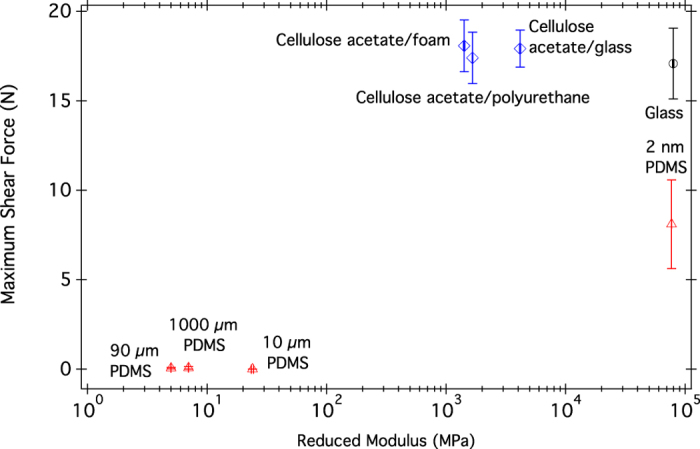
Average maximum shear force of adhesion for whole animals on cellulose acetate and PDMS substrates as a function of the surface modulus of the substrates (as measured using a nanoindenter).Individual points are labeled, and the thicknesses of the surface layer are tabulated in Table 1. Values are means ± standard error, n = 7.